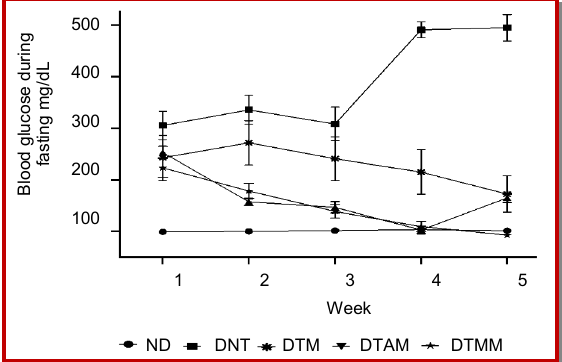
Figure 1: Change in blood glucose during fasting of different groups of mice during the treatment period (Mean ± SEM) n = 6, ND: No Diabetics; UD: Untreated diabetics; DTM: Diabetics treated with metformin; DTAM: Diabetics treated by aqueous macerated; DTMM: Diabetics treated with macerated